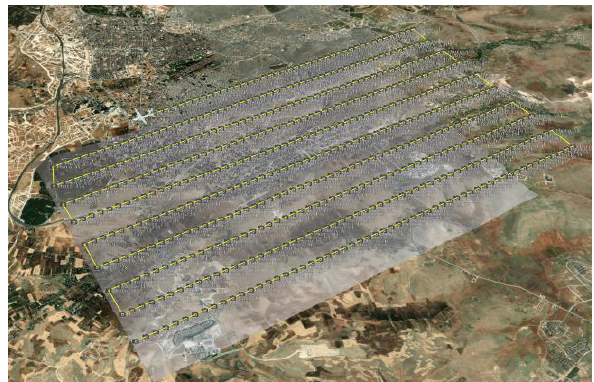
Figure 6 . The photogrammetric flight mission from Bizimsehir project (data courtesy: Buyukdemircioglu and Kocaman, 2020).